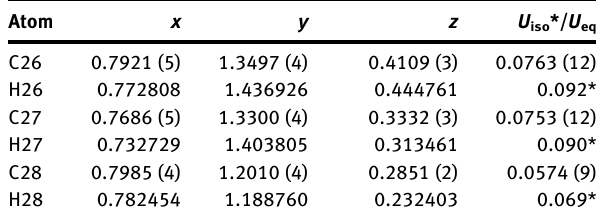
Table  : Fractional atomic coordinates and isotropic or equivalent isotropic displacement parameters (Å 